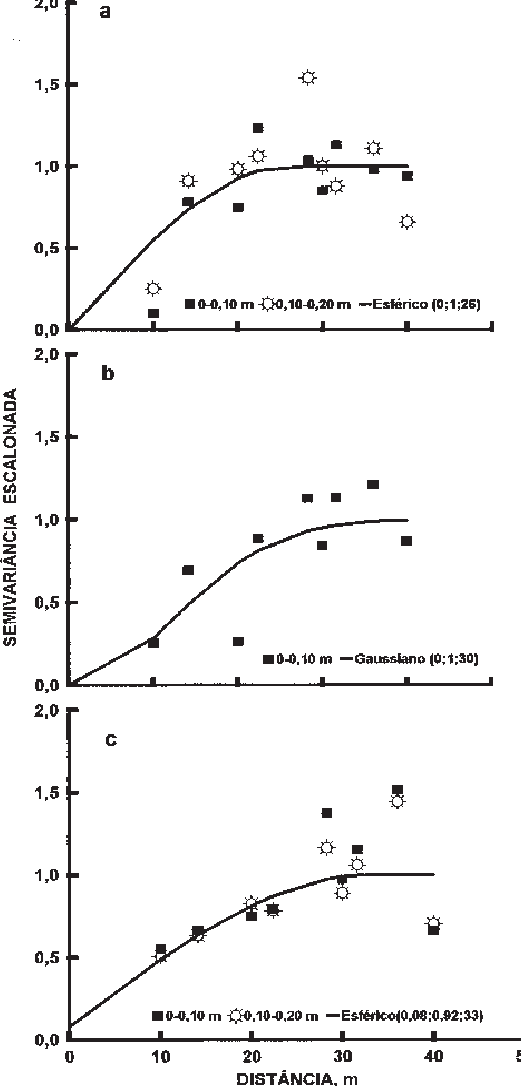
Figura 3. Semivariogramas cruzados da produção de trigo (a) com fósforo, (b) com potássio e (c) com matéria orgânica na área de plantio direto em Passo Fundo (RS). As legendas dos gráficos incluem o modelo ajustado aos dados e, entre parênteses, os coeficientes C 0 , C 1 e alcance da dependência espacial; C 0 + C 1 representam o patamar do